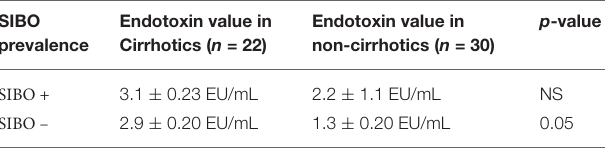
SIBO, small bowel bacterial overgrowth; NS, not